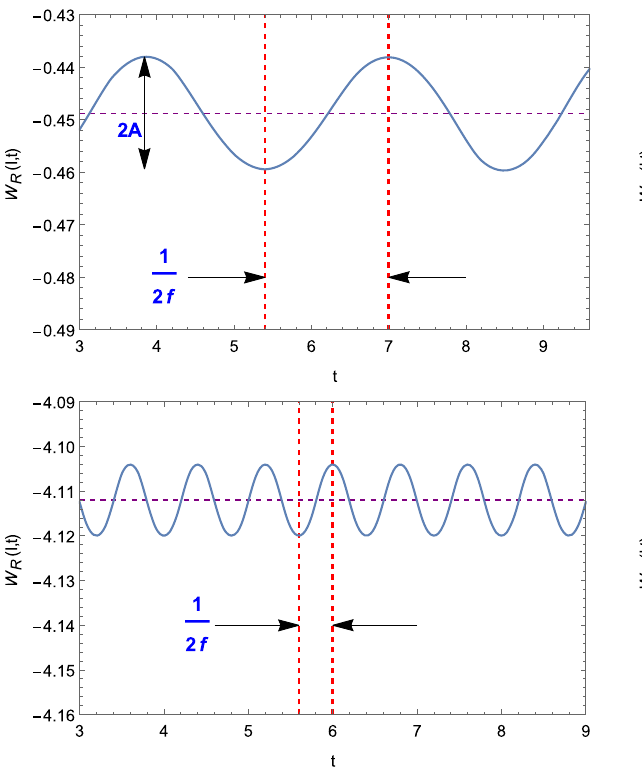
and − 11 . 8713 corresponding to ν = 1 , 2 , 3 and 4, respectively. The dashed purple line shows the static potential in each case. For ν = 1 = 0 . 159, and and 4, we have 2 A = 0 . 0213 and 0.0447, respectively f